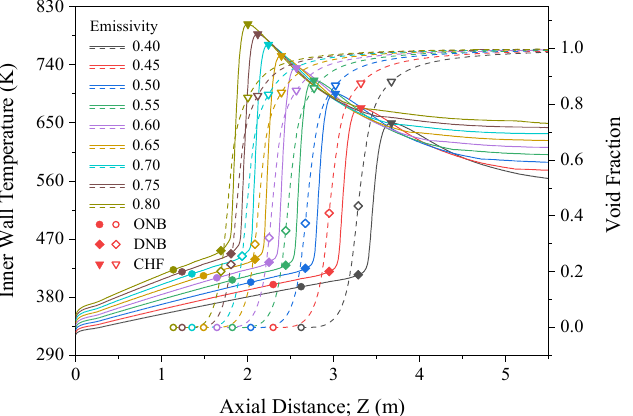
Figure 16. Inner wall temperature distributions along the axial direction under wall emissivity from 0.40 to 0.80.